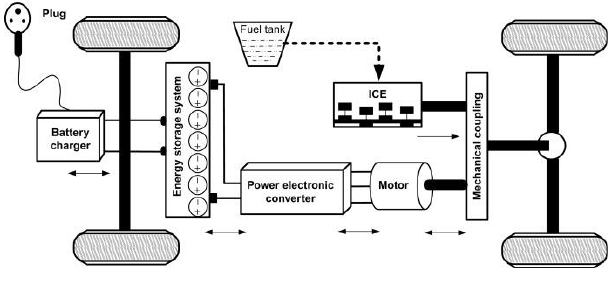
Fig. 1. Architecture of the parallel hybrid electric vehicle